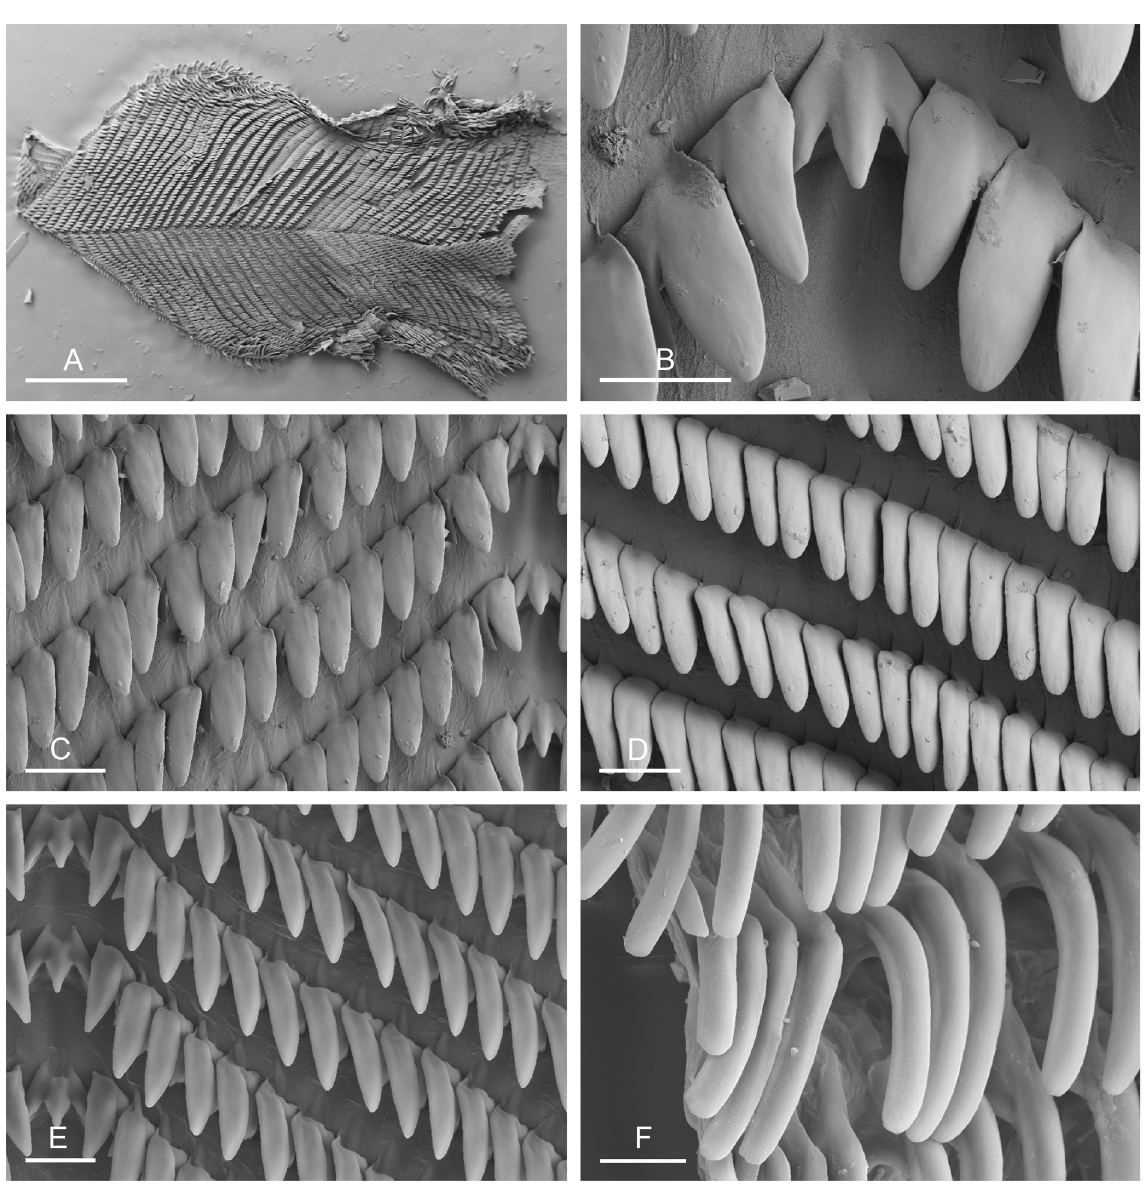
Fig. 43. Paromoionchis penangensis gen. et sp. nov., radula. A – D . Holotype, Malaysia, Penang [6037] (USMMC 00059). A. Entire radula. B. Rachidian and innermost lateral teeth. C. Lateral teeth with rachidian teeth. D. Lateral teeth. E – F . Western Peninsular Malaysia [6020] (USMMC 00062). E. Lateral teeth with rachidian teeth. F. Outermost lateral teeth. Scales: A = 0.5 mm; B, F = 20 μm; C–E = 30